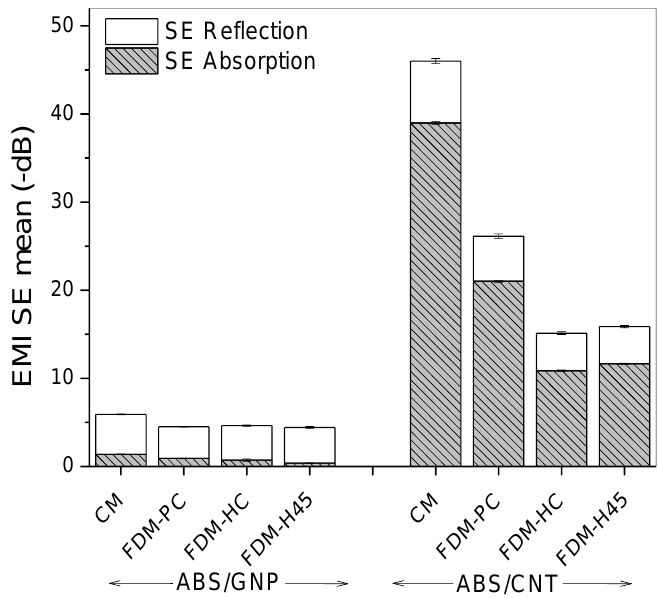
Figure 11. Shielding effectiveness by absorption and reflection of ABS composites.